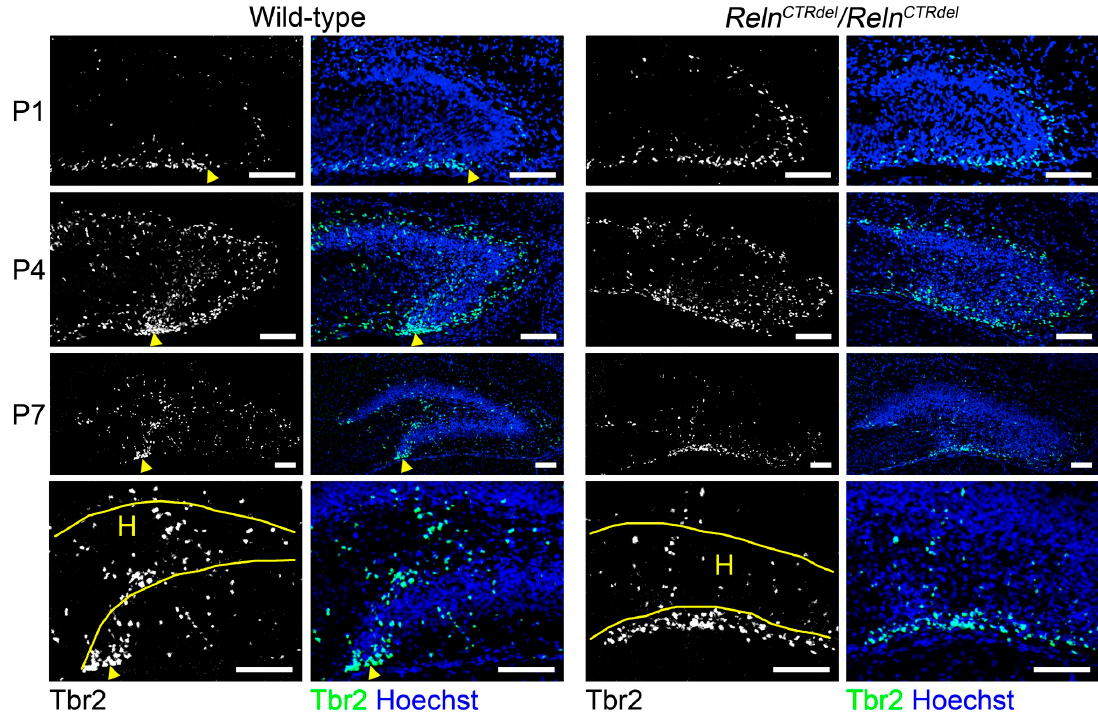
Figure 3. Lack of intermediate progenitor accumulation at the fimbriodentate junction. In wild-type mice, Tbr2-positive cells (gray or green) accumulate at the fimbriodentate junction (arrowheads) starting at P1 ( n = 2 each) and more clearly at P4 ( n = 2 each) and P7 ( n = 2 each). This accumulation at FDJ is less apparent in the mutant, and the labeled cells are spread out along the ventricular surface. Enlarged imaged of the hilus at P7 are shown in the lower panel. Reln CTRdel mice have fewer Tbr2-labeled cells in the hilus (H) compared to wild-type mice; it appears as if many cells are still confined to the ventricular surface. Nuclei were stained using Hoechst (blue). Scale bars, 100 µm.